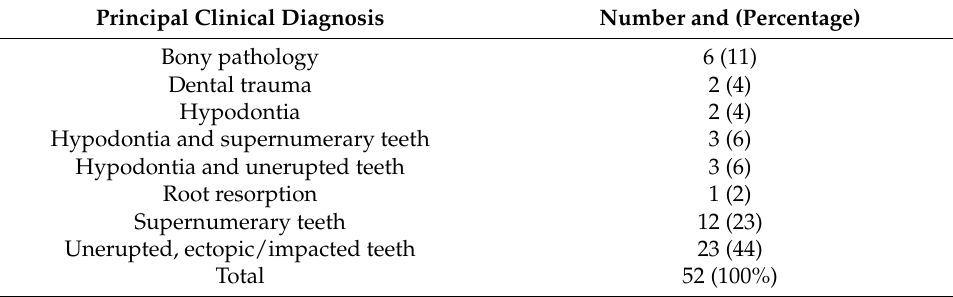
Table 2. Table showing the principal clinical diagnosis of the cases in which a cone beam computed tomography (CBCT) was